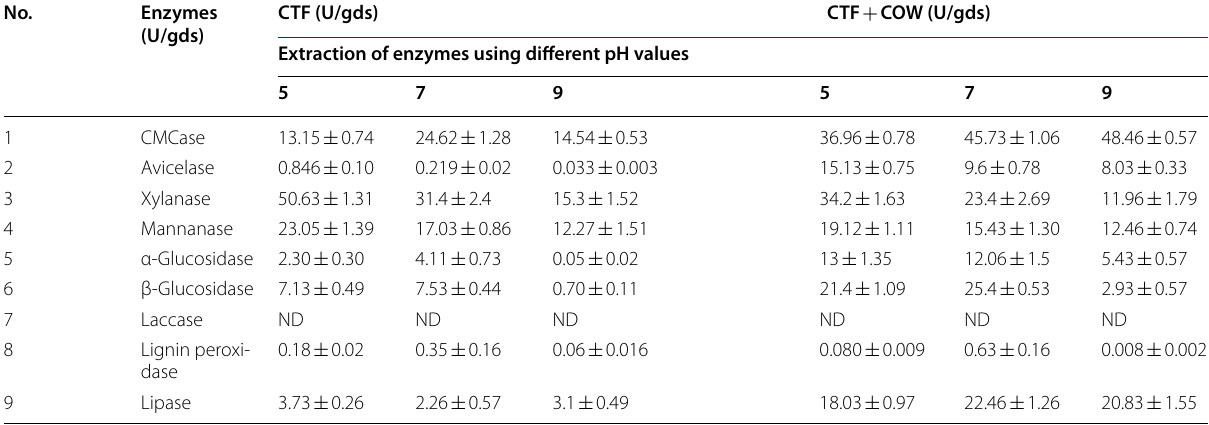
ND not detected